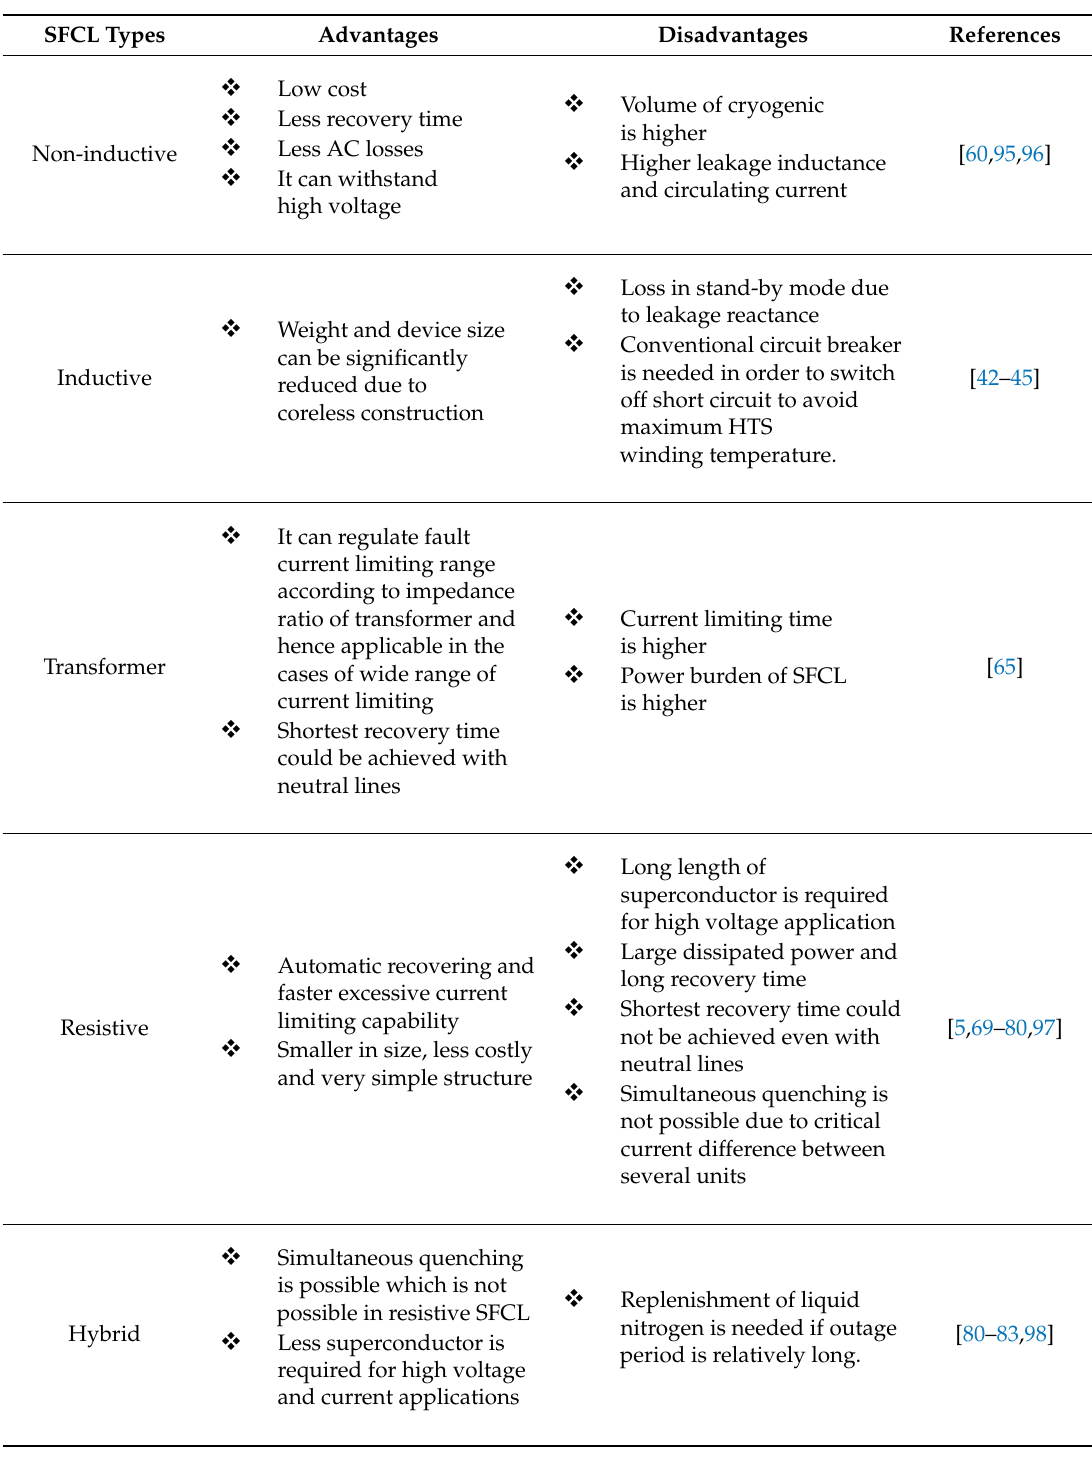
Table 2. Comparisons of different SFCLs in terms application, cost, pros and cons.